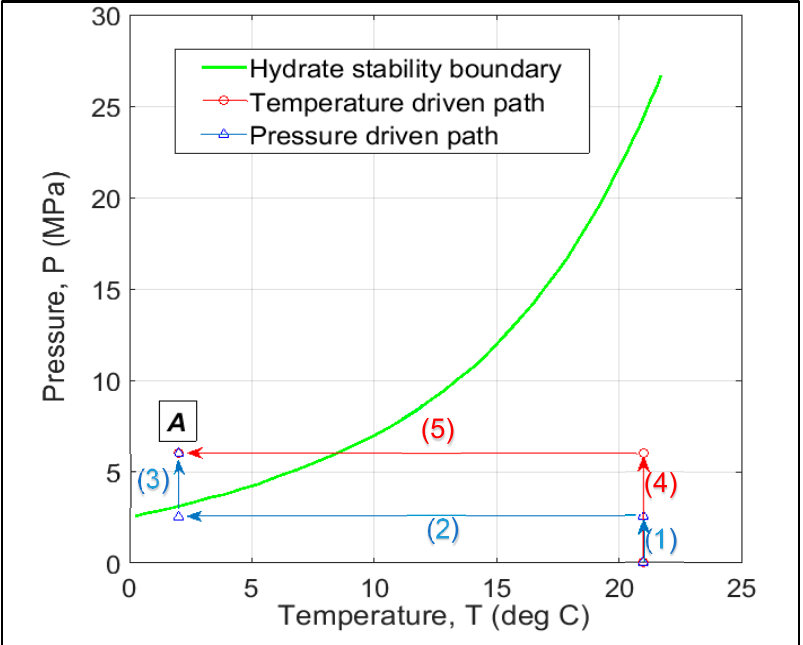
Figure 4. Hydrate stability boundary and the respective paths followed to initiate hydrate formation (Point A represents final P-T condition for all the tests).